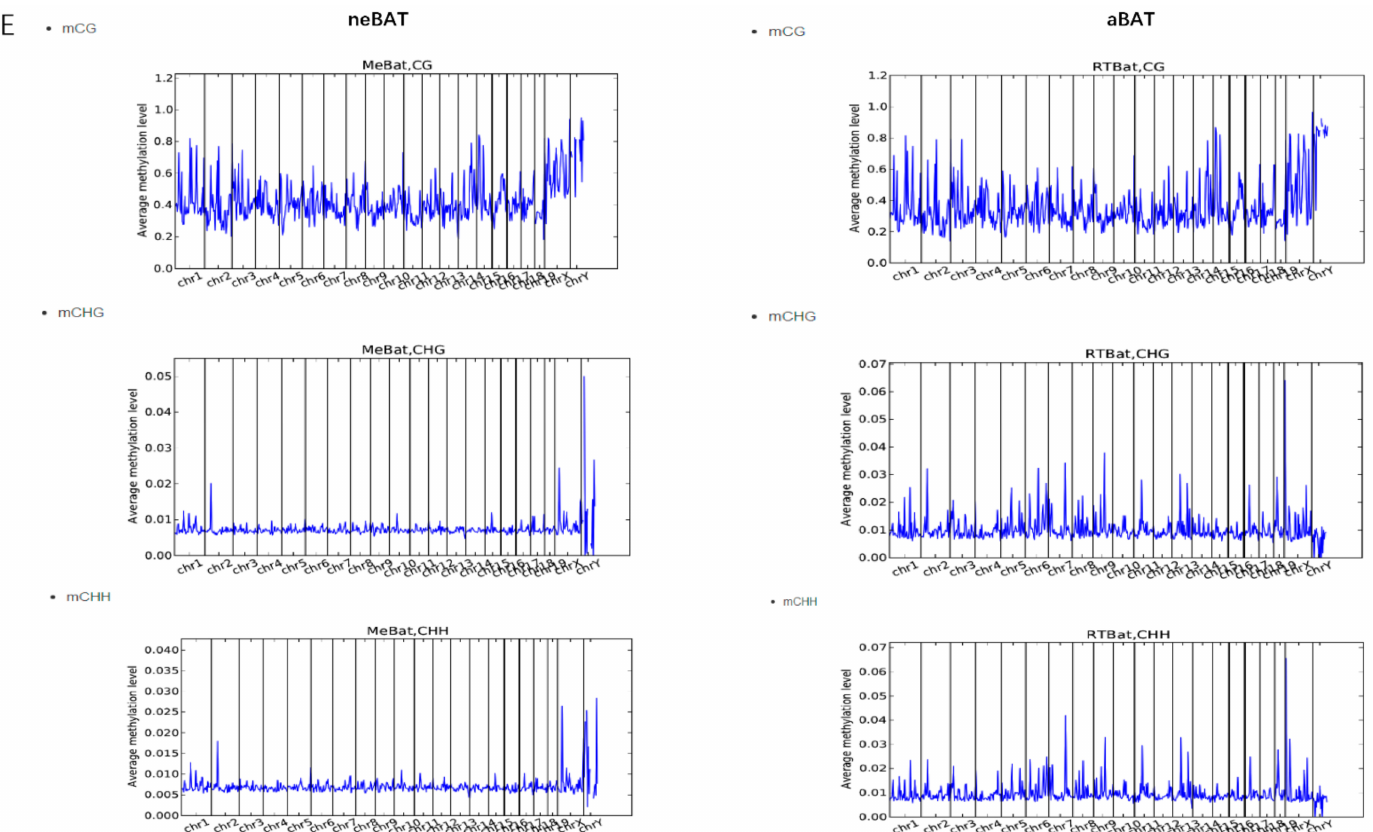
Figure 6. Analysis of DNA methylation patterns of aBATs and neBATs. ( A ) Bulk methylation levels in aBATs and neBATs. The bulk methylation levels were analyzed for cytosine sites with ≥ 10X in each sample using CGmapTools. ( B ) Methylation contributions in aBATs and neBATs. The methylation contributions indicate chances that an observed site could be in a specific context. This analysis was applied to cytosine sites with ≥ 10X in each sample using CGmapTools. H = {A, C, T} and W = {C, T}. ( C ) This heat map shows the average methylation levels of CG in bins across whole genomes. The color indicates the average methylation levels in bins across the whole genome (bin size: 5 Mb). Green bars on the right indicate the global average DNA methylation levels. ( D ) Di ff erentially methylated region (DMR) analysis was conducted by CGmapTools using the dynamic region strategy. ( E ) Distribution of mCG, mCHG, and mCHH in bins for neBATs and